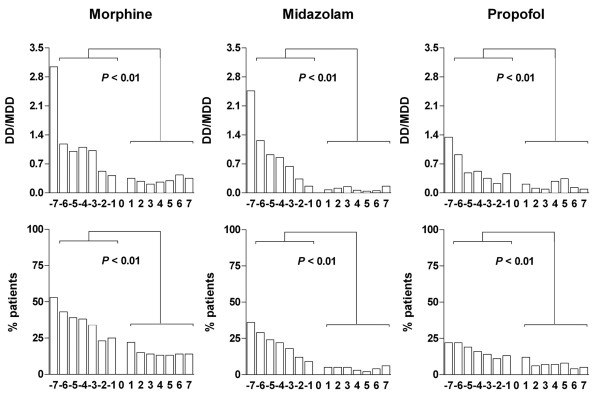
Daily administration of morphine, midazolam and propofol and percentages of patients needing these sedatives. Data are expressed as mean DD/MDD. When comparing the summed data of seven days before and after tracheotomy there was a significant difference in dosage and percentage of patients using these sedatives before and after tracheotomy (P < 0.01 with the Wilcoxon signed-rank test and the McNemar test). However, a repeated-measurements analysis of variance showed that, from day -7 to day -1, morphine dosage declined by 3.34 (95% confidence interval -1.61 to -6.24), midazolam dosage by 2.95 (-1.49 to -5.29) and propofol dosage by 1.05 (-0.41 to -2.01) DD/MDD (P < 0.01). The percentage of patients using sedatives also decreased before tracheotomy. After tracheotomy there was no further increase in decline rate, and the dosage remained stable.